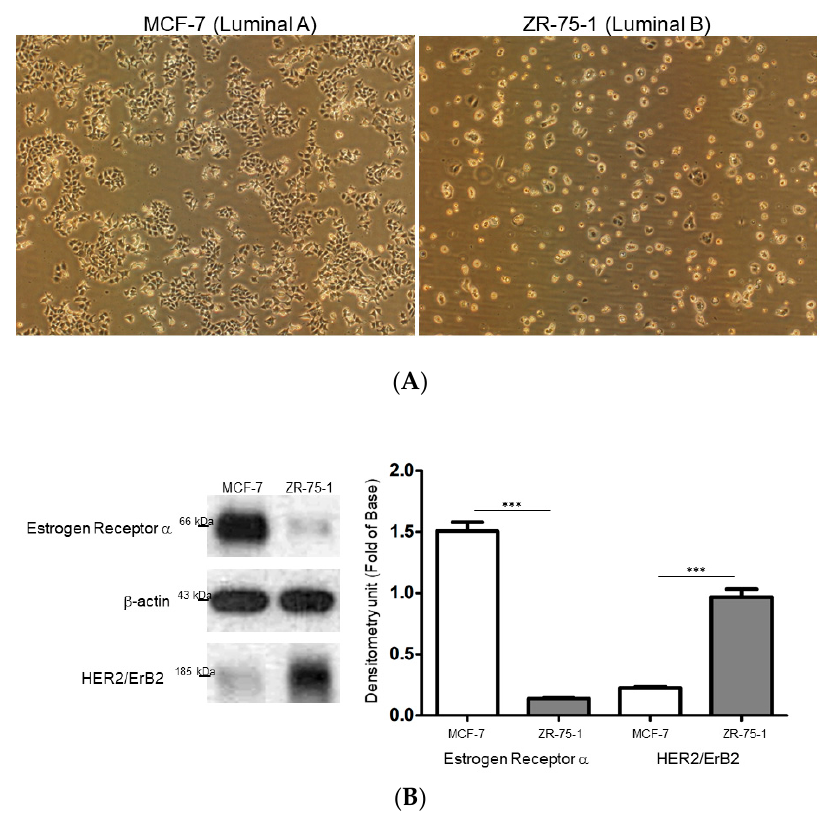
Figure 1. ( A ) Morphological comparison between MCF-7 and ZR-75-1 cells. Original magnification: 100×. ( B ) Evaluation of the levels of ER and HER2 in MCF-7 and ZR-75-1 cells. The quantified results were demonstrated by the bar chart and data were the mean ± SD of three independent experiments. β -actin was utilized as a loading control and (*** p < 0.001).